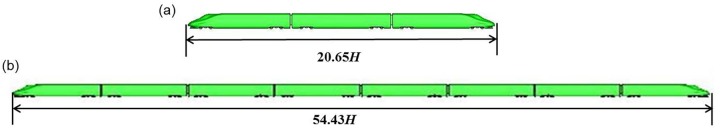
High-speed train models.(a) three-car grouping model; (b) eight-car grouping model.